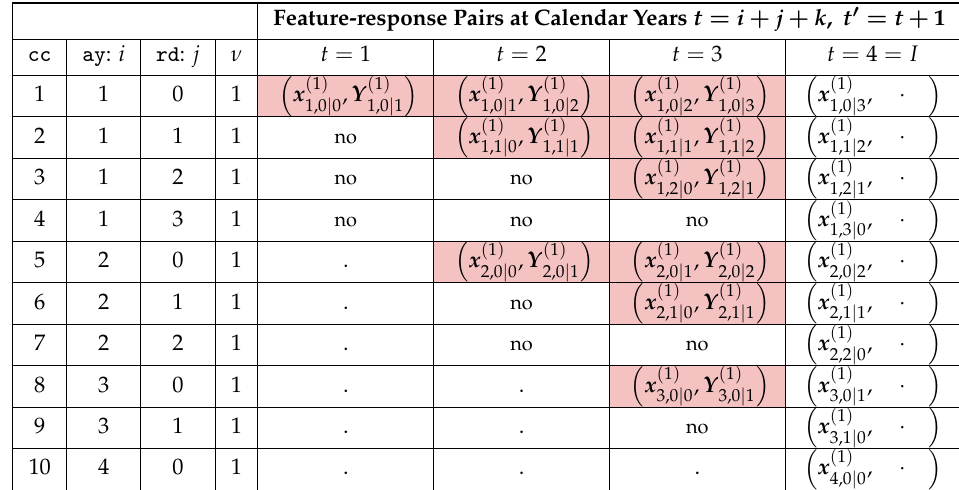
Table 1. Pairs feature-response observed at time I = 4 for a claims portfolio with N i , j ≡ 1. In cells with “no” features are not observed because of reporting delay. Responses on the last column are not yet observed.